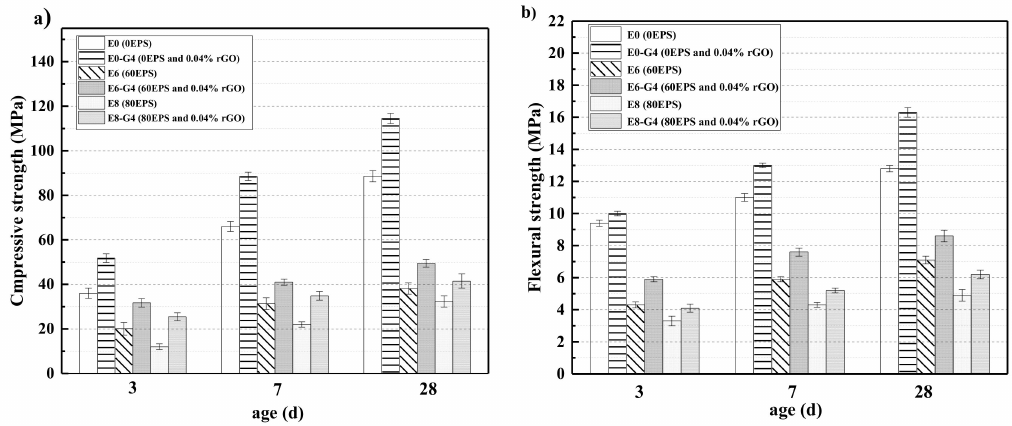
Figure 10. Mechanical strengths of rGO-WEA sample at di ff erent curing ages: ( a ) compressive strength and ( b ) flexural strength.